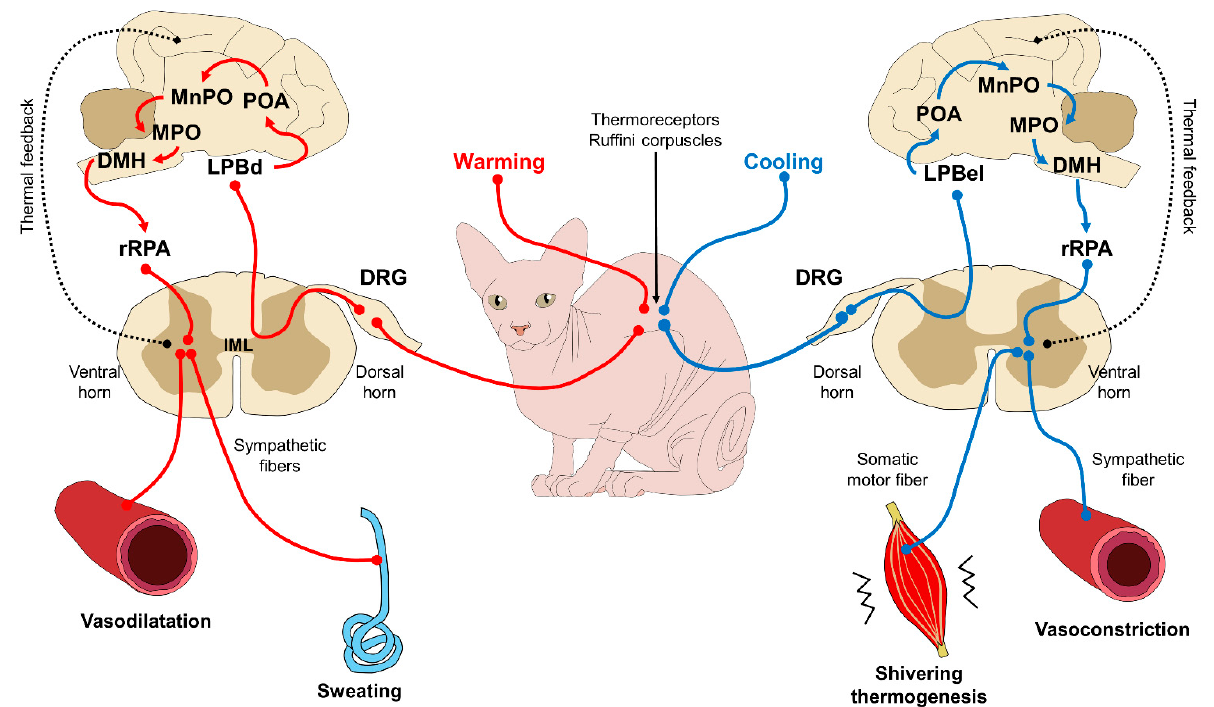
Figure 3. Control mechanisms to regulate body temperature via feedback. Thermoreceptors (Ruffino corpuscles) located in the periphery of the skin sense thermal inputs that are processed by different pathways, depending on the sensory information. The path from the left represents a situation where thermoreceptors read warm or hot stimuli. This input is conducted to the DRG of the spinal cord and projected to superior brain centers. The neuronal axons located in the LPBd are activated by warming stimulus, and project to the POA and other structures within the POA, such as MnPO and MPO. Before returning to the spinal cord, the input goes through the DMH, the rRPA, and reaches the ventral horn, where sympathetic fibers act on blood vessels and glands to dissipate heat by vasodilatation and sweating. The cooling pathway from the right follows almost the exact pattern, except that when a cooling signal is perceived from the thermoreceptors, the information reaches the POA through LPBel (instead of the LPBd). Additionally, the efferent responses employ sympathetic fibers for the vasoconstriction of the skin vessels to conserve heat, and somatic motor fibers start the thermogenesis in the muscles by shivering. When the core temperature returns to thermal neutrality, these mechanisms are regulated with feedback to hinder their influence on the vasculature and other structures. DMH: dorsomedial hypothalamus; DRG: dorsal root ganglion; IML: intermediolateral cell column; LPBd: lateral parabrachial nucleus (dorsal subregion); LPBel: lateral parabrachial nucleus (external lateral region); MPO: medial preoptic area: MnPO: median preoptic nucleus; POA; preoptic area; rRPA: rostral raphe pallidus nucleus.